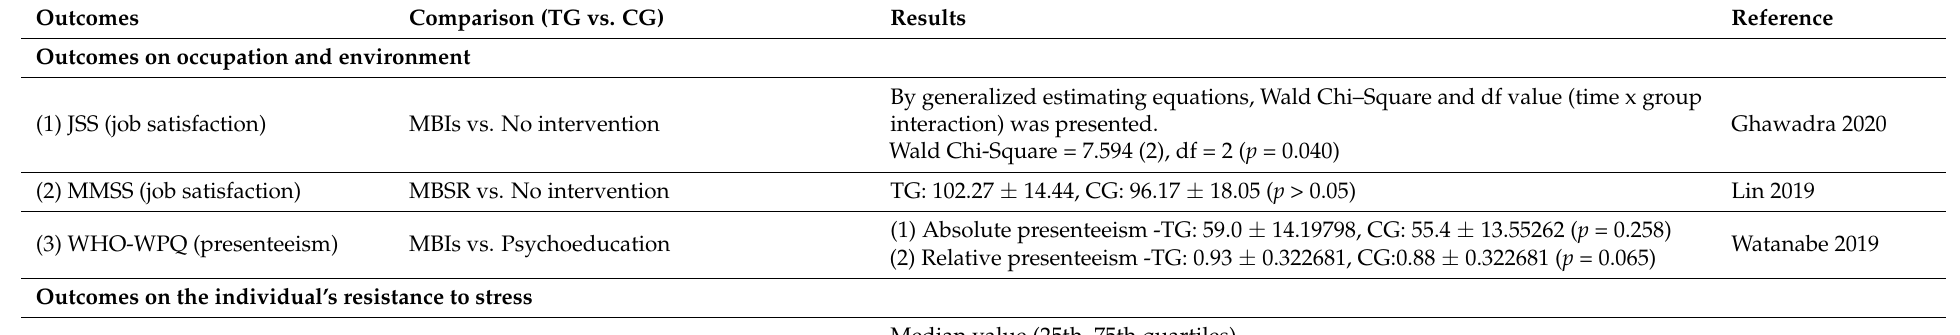
Table 2. Main results of included